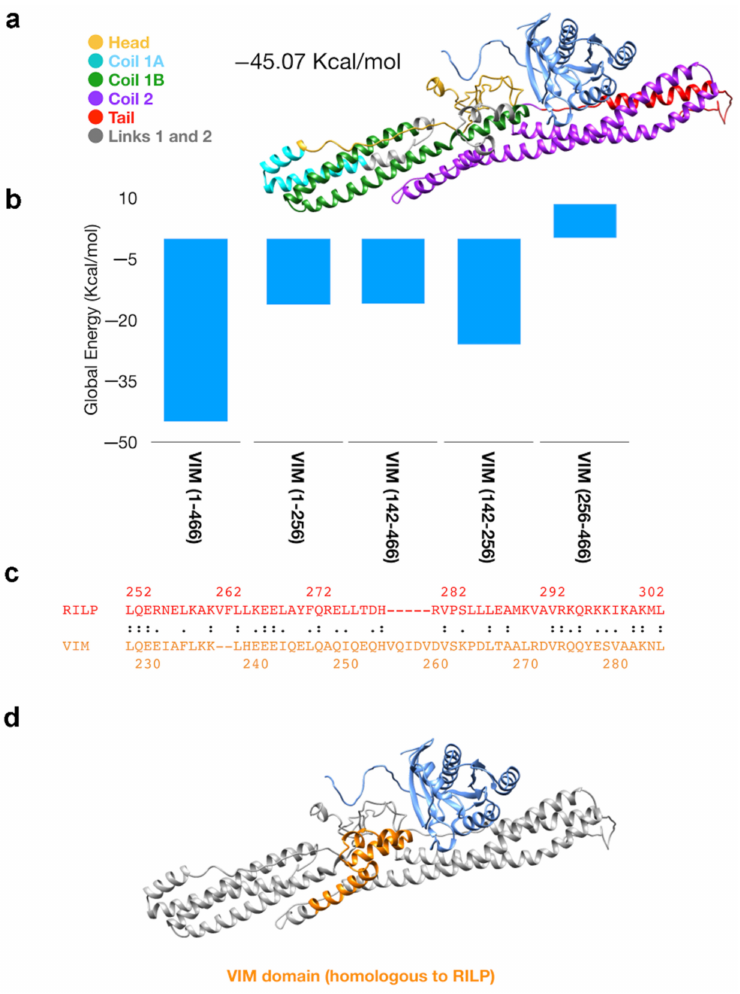
Figure 2. Docking results and 3D model of vimentin-RAB7A complex. ( a ) 3D structure of the best result obtained performing Gramm-X followed by FireDock simulations. We used the vimentin model as the receptor and RAB7A model as the ligand (cornflower blue). The domains of vimentin are marked in different colors as indicated. ( b ) results obtained by Patchdock and FireDock simulation using as receptor the truncated models of the vimentin. ( c ) homology between the sequence of Rab interacting lysosomal protein (RILP) (red) and the sequence of vimentin (orange) calculated by LALIGN server. ( d ) 3D representation of vimentin-RAB7A complex (showed also in panel A) with the region homologous to RILP marked in